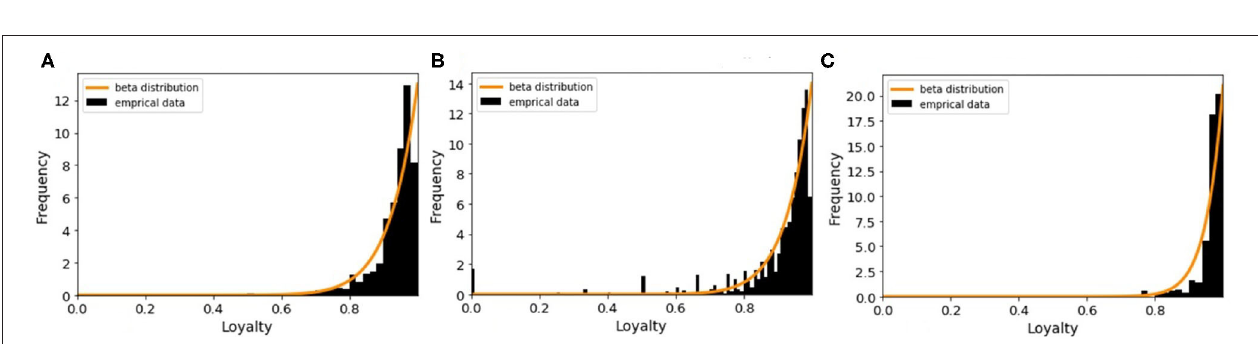
FIGURE 7 | The histogram of loyalty values and its fitted random distribution function for different farm types (A) breeding farms, (B) fattening farms, and (C) traders.